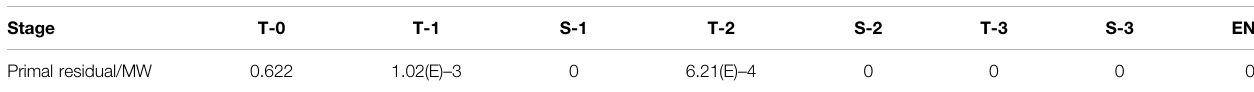
TABLE 2 | Primal residuals of transaction power at the end of each stage of distributed economic dispatch.